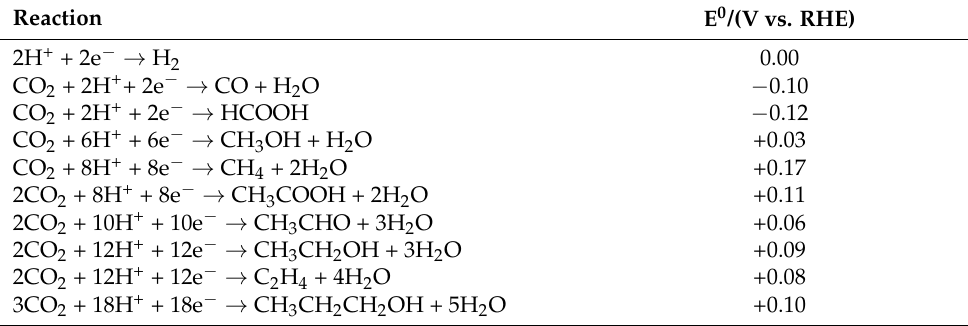
Table 1. Electrochemical reactions and their equilibrium potentials.